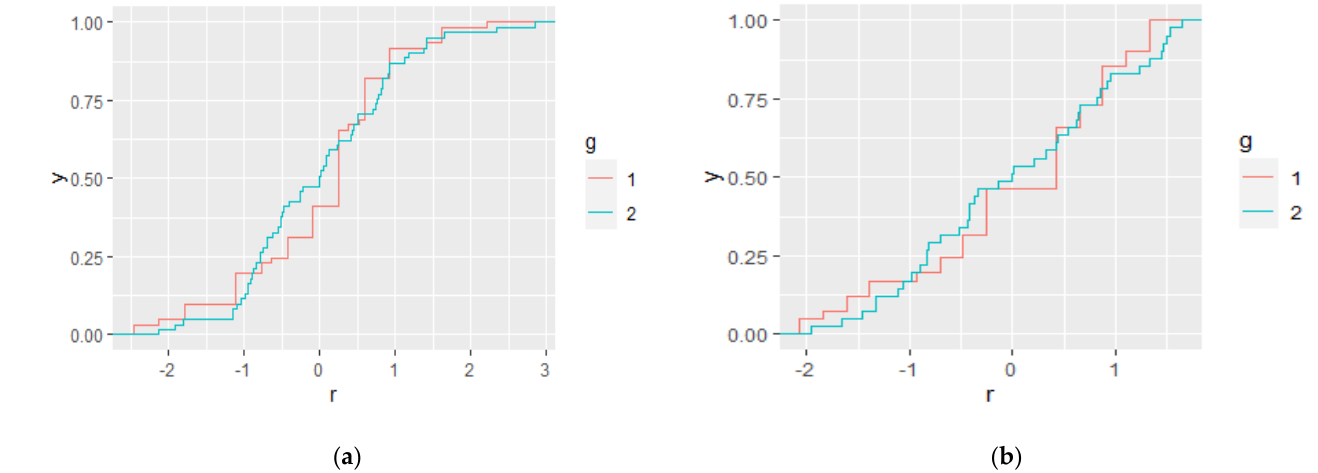
Figure 11. ( a , b ) — Obtained with R package ggplot2. ( a ) Data set 1: Kolmogorov test for teacher and lCLV standardised classifications distributions; ( b ) Data set 3: Kolmogorov test for HIP (hired teacher) and lCLV standardised classifications.